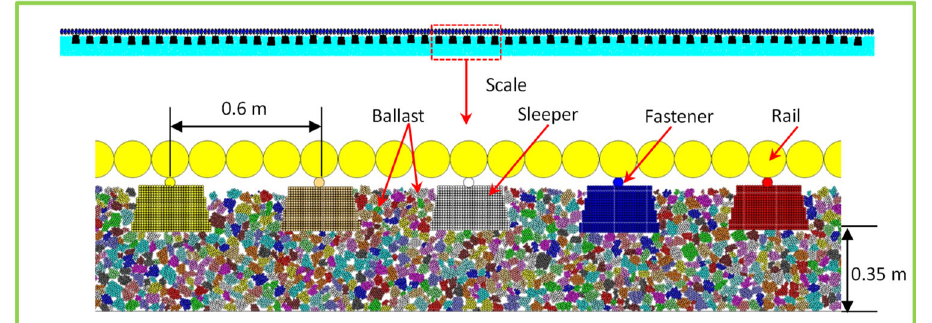
Fig. 7 The DEM for railway ballasted